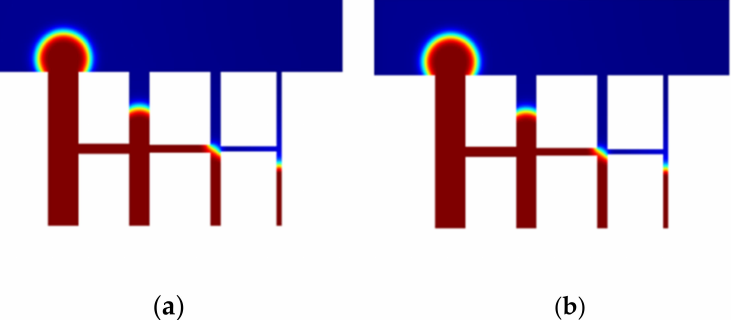
Figure 10. ( a ) With gravity and inertial forces. ( b ) Without gravity and inertial forces (blue area represents water and red area represents